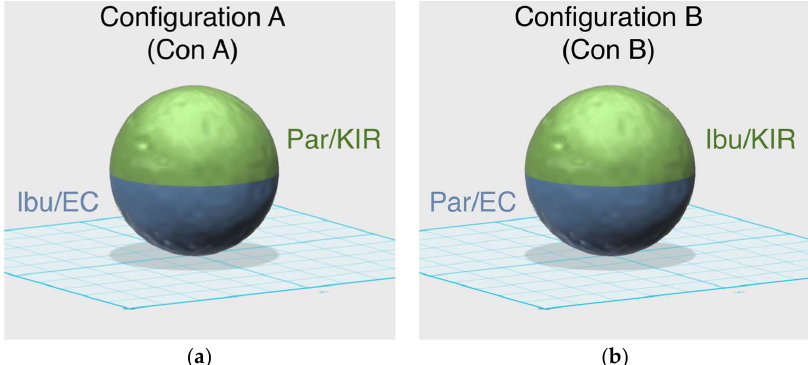
Figure 1. Schematic representation of the compositions of ( a ) configuration A and ( b ) configuration B of the dual miniprintlets.